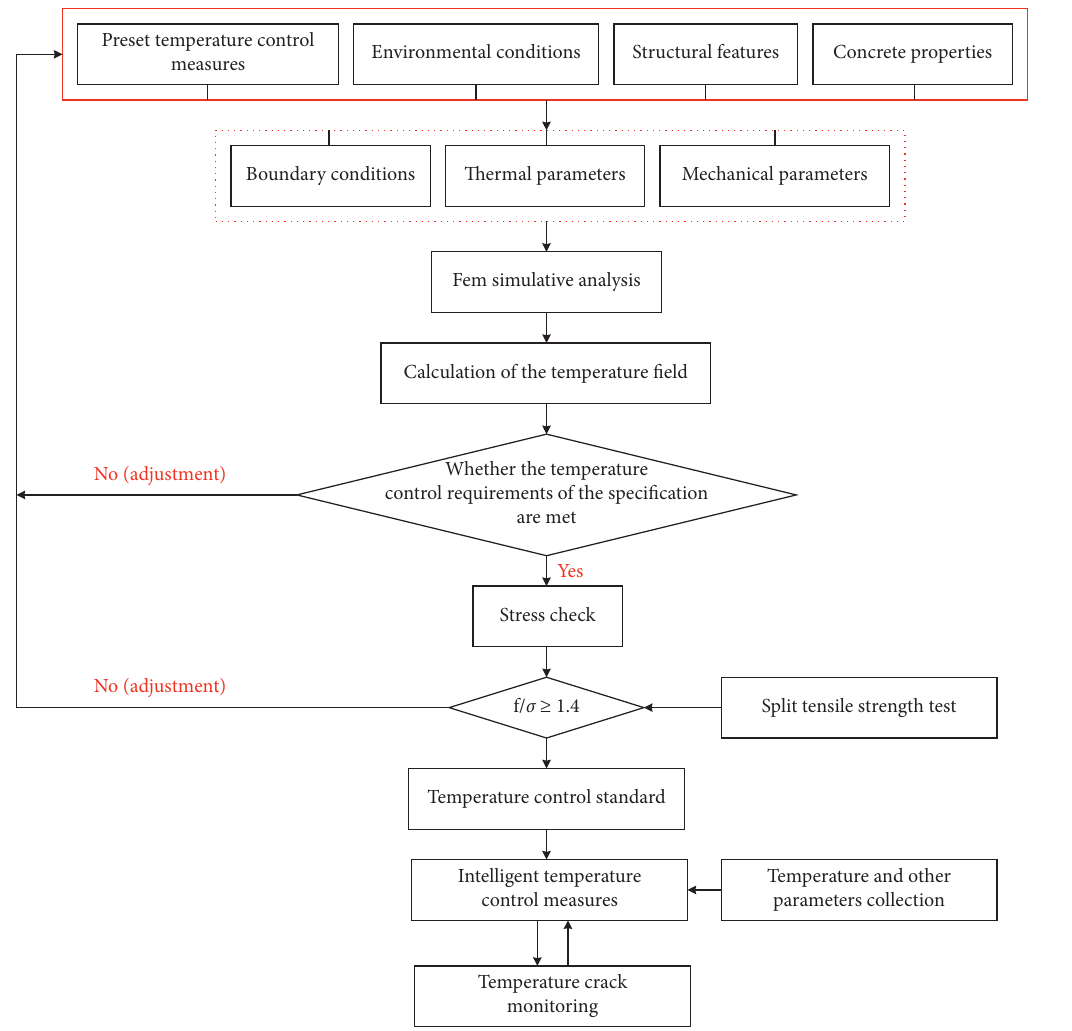
Figure 2: Temperature control Table 1: The lithology parameters of the 3D model.